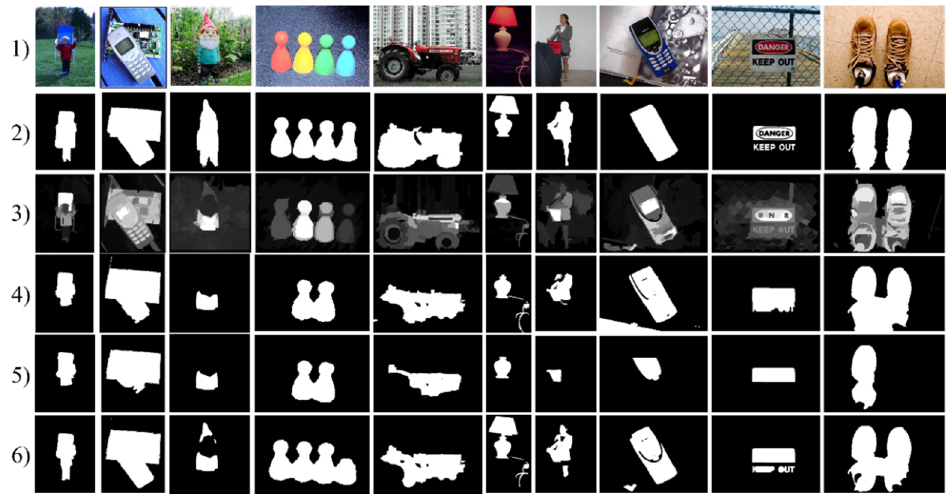
Figure 9. Visual comparison between saliency cuts methods. From top to bottom: (1) input images, (2) ground truth, (3) saliency maps, (4) ATT_Cuts [16], (5) RC_Cuts [17], (6) the proposed method.